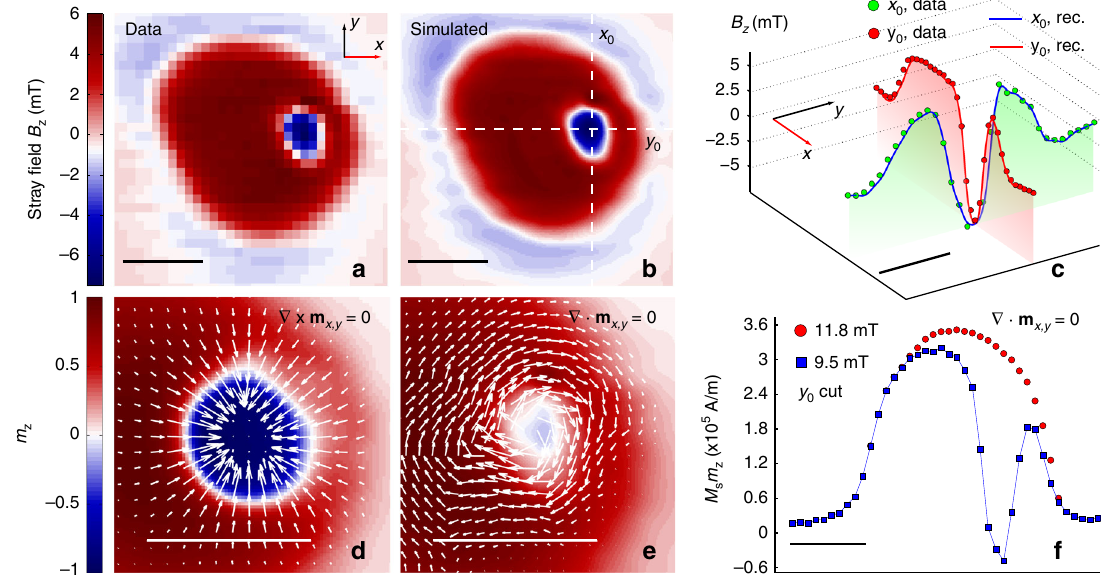
Fig. 3 Extracting the local magnetic structure of the skyrmion. a z -component of the stray fi eld from measured data at a bias fi eld of B ||,ext = 9.5 mT applied along the [111] diamond axis. Since a single component of B contains all relevant information, B z is chosen for comparison with simulations due to its particularly symmetric coupling to m z (see text). b Simulated map of B z in both the Bloch and the Néel gauge. c Cuts along the x = x 0 and y = y 0 lines shown in b (solid lines) and comparison with experimental data in a (markers). d Magnetic structure obtained in the Néel gauge (see Supplementary Note 3). It preserves normalization of the local magnetization and produces a stray magnetic fi eld that matches the experimental results. The colour map shows the m fi le from a round shape are most likely z component. White arrows are proportional to the in-plane magnetization. The deviations of the skyrmion pro related to disc edge effects. e Plot similar to the one in d , obtained by choosing the Bloch gauge. The local magnetization at the centre of the skyrmion in this case is mostly in-plane. f Comparison between the reconstructed M s m z local magnetization component in the Bloch gauge at two different bias fi elds (9.5 and 11.8 mT). The m z pro fi le at saturation (11.8 mT) is used to normalize the local moments for the magnetic structure simulations shown in d , e